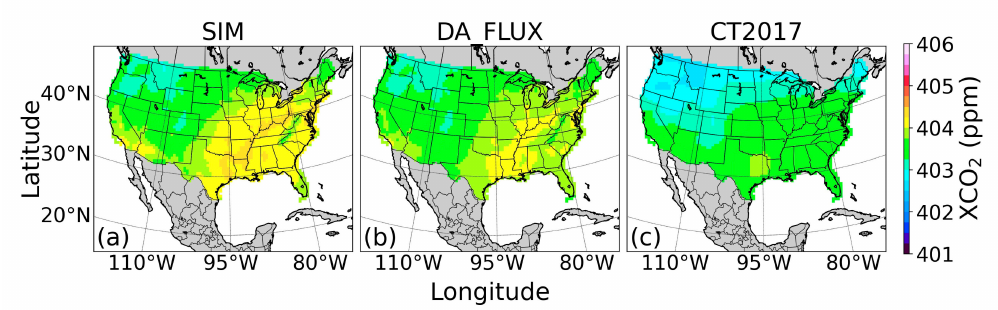
Figure 9. Annual mean XCO 2 distribution over the contiguous United States in 2016 from the SIM ( a ), DA_FLUX ( b ) experiments, and CT2017 ( c